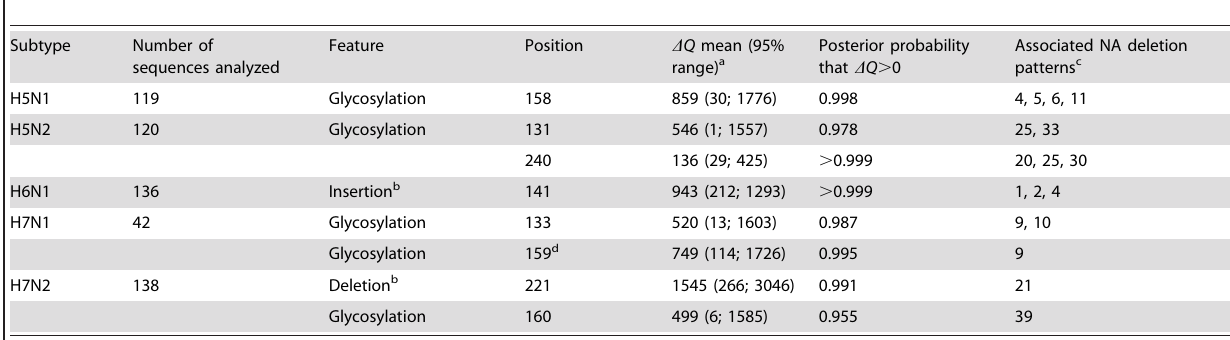
Table 4. Bayesian estimation of joint transitions between full-length NA and S D NA and selected HA features.